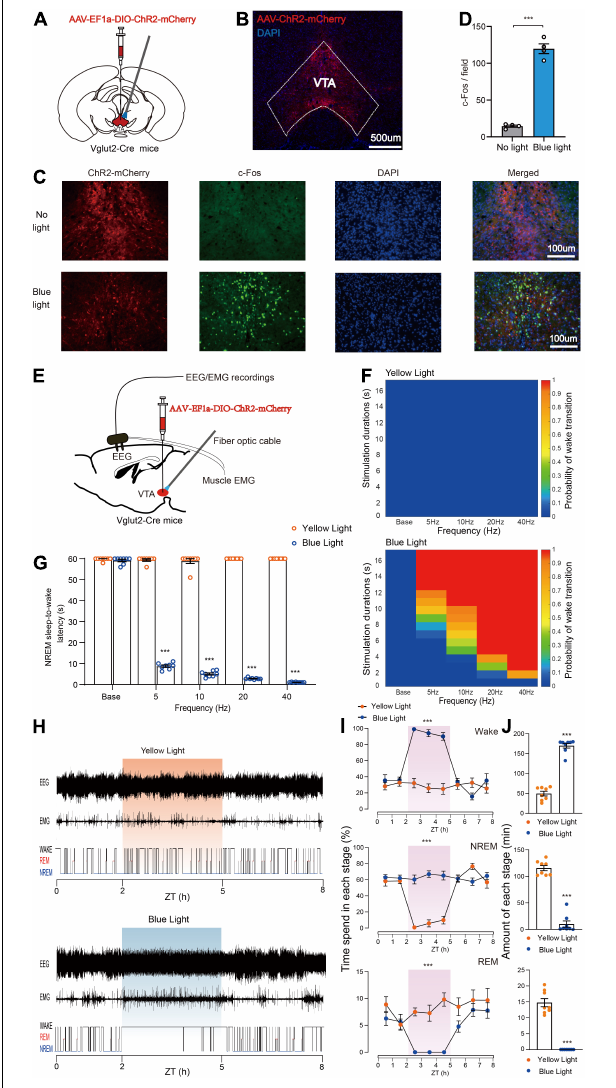
FIGURE 1 | Photoactivation of VTA glutamatergic neurons initiates and maintains wakefulness. (A) Schematic of AAV-EF1a-DIO-ChR2-mCherry expression in the VTA. (B) Representative fluorescent image showing restrictive expression of ChR2-mCherry in the VTA area. (C) Fluorescent images showing c-Fos expression in the VTA without (top) or with blue light stimulation. (D) Quantitative analyses of c-Fos expression ( n = 4, 8 sections for each group. Two-tailed unpaired t -test; t 6 = 15.50, P < 0.001). (E) Diagram of photostimulation of VTA glutamatergic neurons. (F) Heat maps showing the probability of NREM-Wake transition. (G) Latencies of NREM-Wake transition upon stimulation with different frequencies of light ( n = 8 per group, paired t -test; Base, t 7 = 1.187, P = 0.2741; 5 Hz, t 7 = 90.60, P < 0.001; 10 Hz, t 7 = 44.12, P < 0.001; 20 Hz, t 7 = 397.1, P < 0.001; 40 Hz, t 7 = 1200, P < 0.001). (H) Example of EEG/EMG traces showing the effects of light stimulation of VTA glutamatergic neurons on sleep–wake behaviors. (I) Time course change in sleep–wake behaviors during long-term photostimulation of VTA glutamatergic neurons during ZT 02:00–05:00 [ n = 8, two-way repeated-measures ANOVA; wake F (1,14) = 51.74, P < 0.001; NREM F (1,14) = 50.06, P < 0.001; REM F (1,14) = 23.66, P < 0.001]. (J) Sleep and wake amount during 3-h long-term light stimulation ( n = 8, paired t -test; wake t 7 = 17.93, P < 0.001; NREM t 7 = 15.98, P < 0.001; REM t 7 = 11.47, P < 0.001). Data are expressed as the mean ± SEM. *** P <